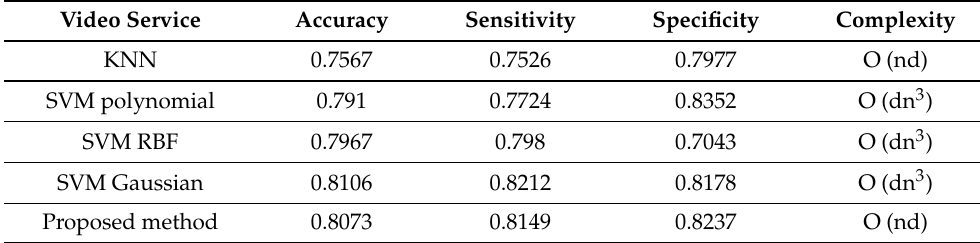
Table 6. Comparison results of various algorithms.